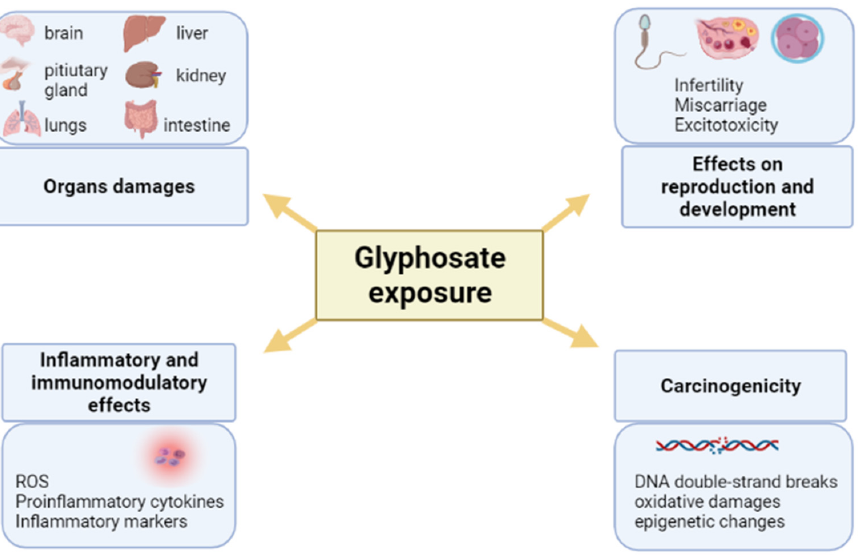
Figure 5. Schematic overview of glyphosate- and GBHs-induced effects. Image has been created with BioRender.com, accessed on 1 November